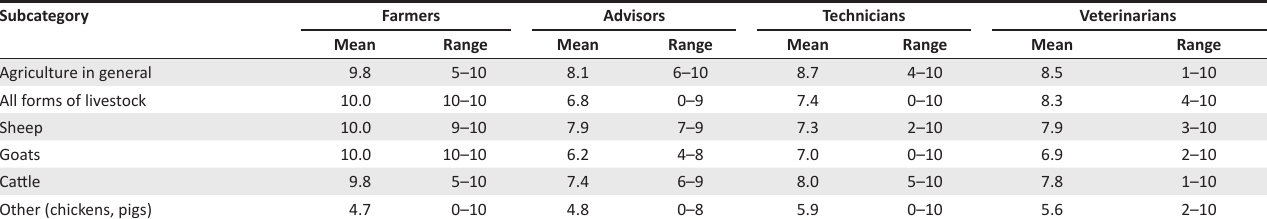
TABLE 1: Importance of agriculture to the standard of living. Subcategory